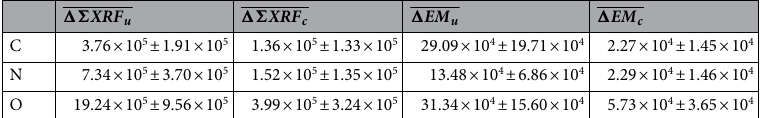
(1.36 × 10 5 ± 1.33 × 10 5 for C, 1.52 × 10 5 ± 1.35 × 10 5 for N and 3.99 × 10 5 ± 3.24 × 10 5 for O) and in case of EM ij (2.27 × 10 4 ± 1.45 × 10 4 for C, 2.29 × 10 4 ± 1.46 × 10 4 for N and 5.73 × 10 4 ± 3.65 × 10 4 for O) images.